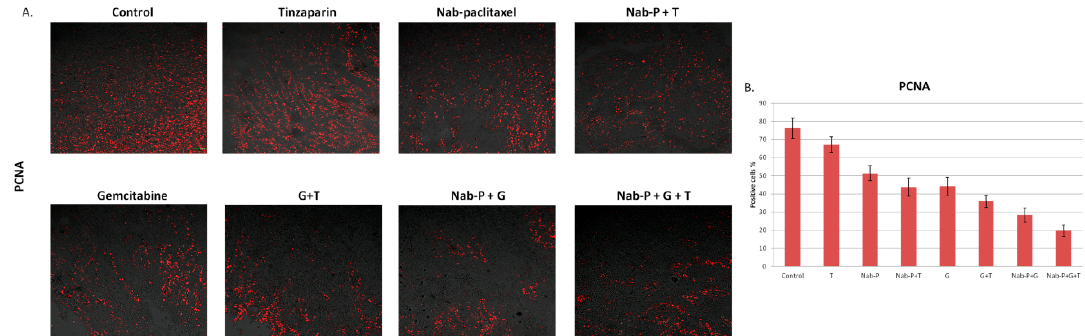
Figure 4. Tinzaparin leads to reduced proliferation when used in combination with chemotherapeutic drugs. ( A ) Im- munofluorescence with PCNA antibody to 4 μ m paraffin sections. Representative images (PCNA-red spots and tissue-bright field) of each group (control, tinzaparin, nab-paclitaxel, nab-paclitaxel + tinzaparin, gemcitabine, gemcitabine + tinzaparin, nab-paclitaxel + gemcitabine, nab-paclitaxel + gemcitabine + tinzaparin) at 100× magnification, scale bar = 100 μ m. ( B ) Diagram showing the percentage of positive stained cells. n = 10/group. All data represent mean ± SD.